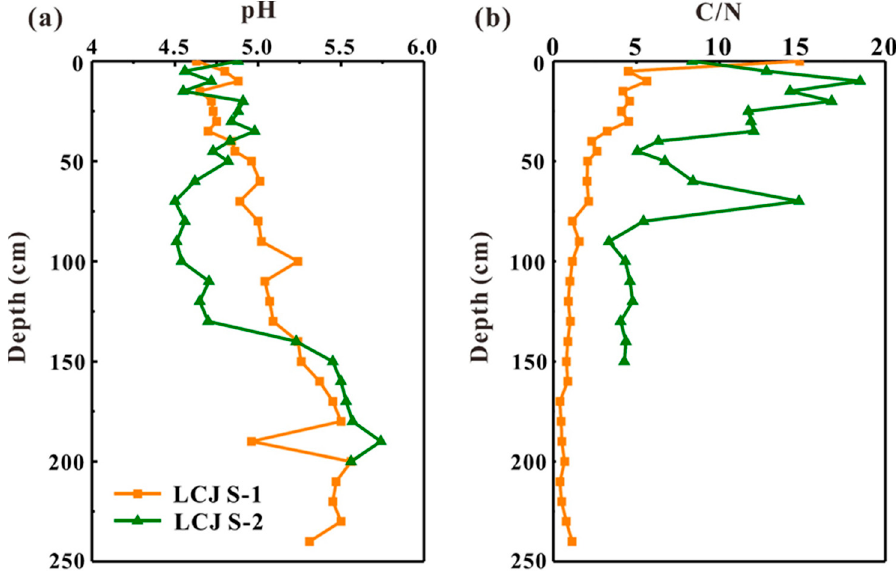
Figure 3. Vertical distribution of soil pH ( a ) and C/N ratios ( b ) in soil profiles. (SON contents of some soil samples were lower than the instrument detection limit, so some C/N ratios weren’t obtained).